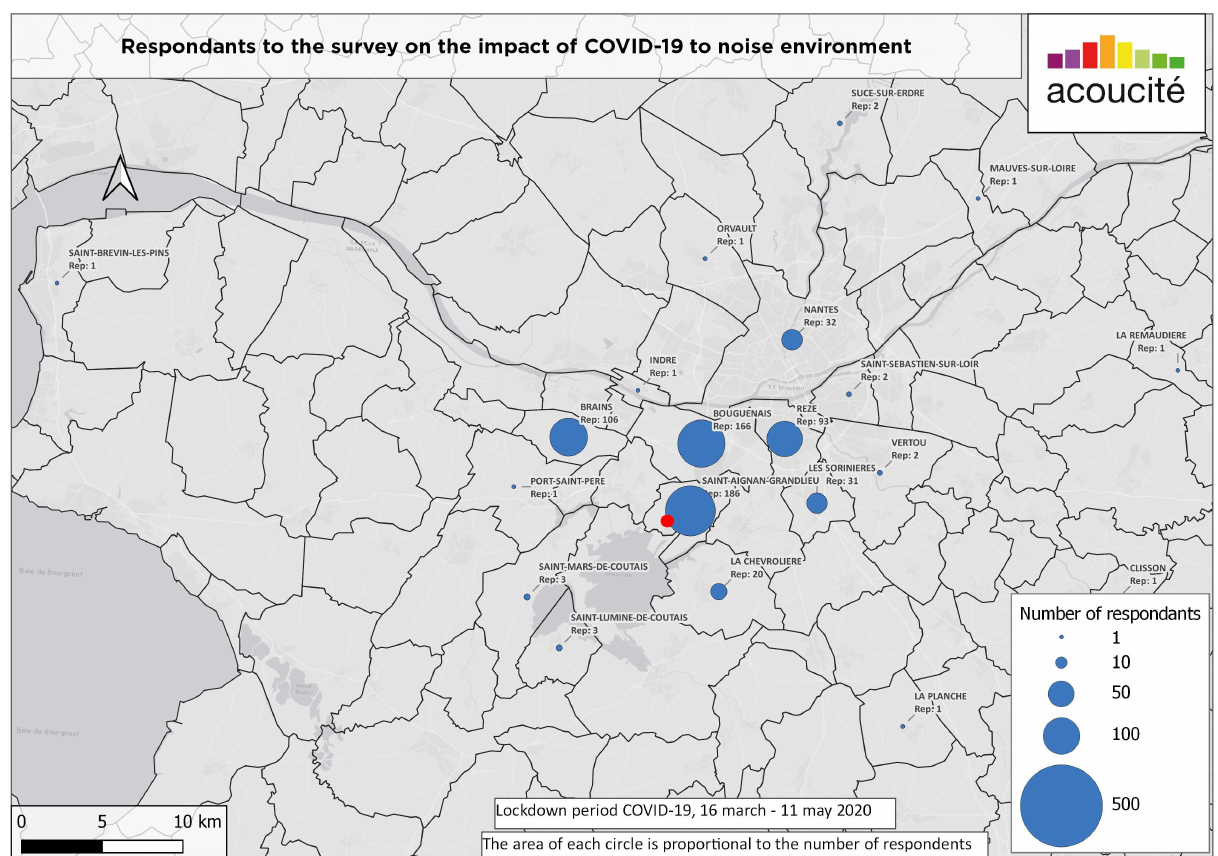
Figure 2: Geographical distribution of respondents. Detailed view of Metropolis of Nantes The airport marked as • is located 47 ∘ 09’26.6"N 1 ∘ 36’22.4"W (more details in appendix